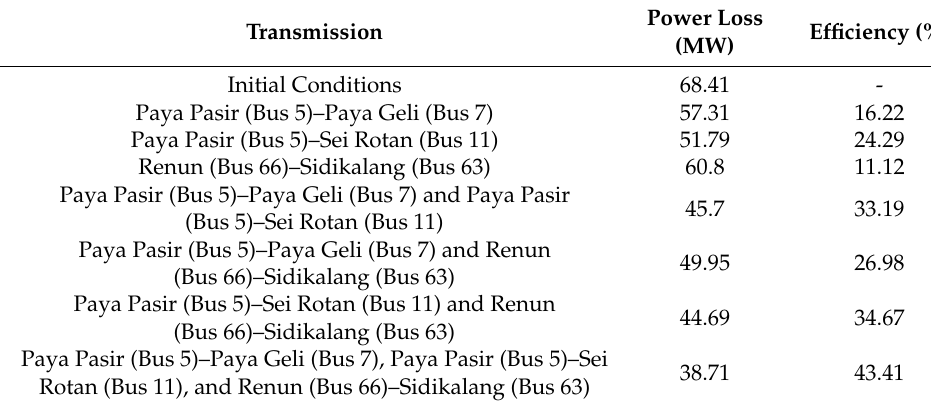
Table 2. Power Loss in the Hybrid HVAC/HVDC system.